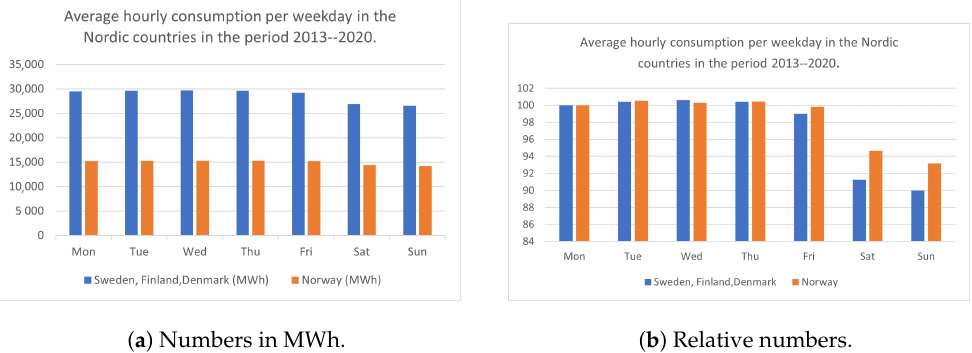
Figure 3. Average consumption per hour by day in absolute numbers ( a ) and compared to Monday ( b ) in the years 2013–2020 in the Nordic countries. Monday consumption is equal to 100. Table 4. The relative and absolute hourly consumption during the week in Norway and the other Nordic countries (sum of consumption in Sweden, Finland, and Denmark) in the period of 2013–2020. - Mon Tue Wed Thu Fri Sat Sun Other Nordic (%) 100.0 100.4 100.6 100.4 99.0 91.3 90.0 Norway (%) 100.0 100.5 Other Nordic (MWh) 29,520 Norway